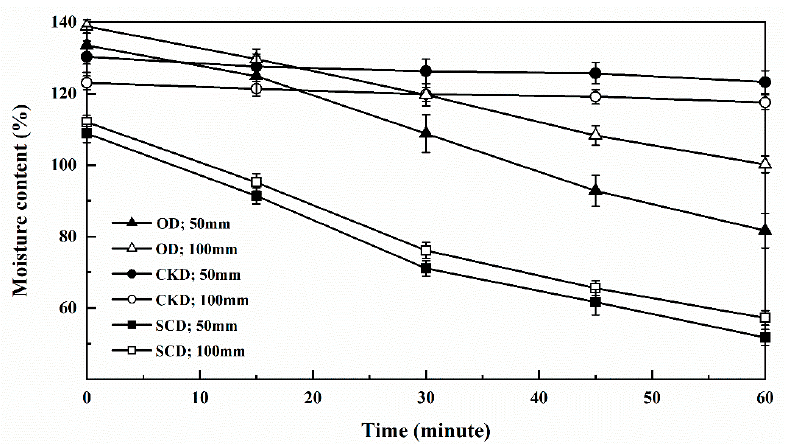
Figure 4. Curves of moisture content (MC) against the time of specimens of different drying methods.